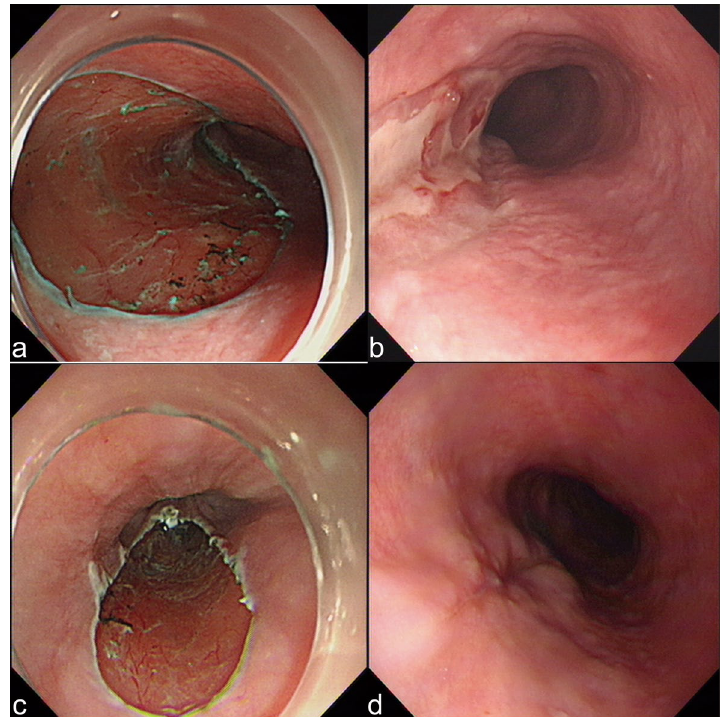
Figure 4. Artificial wounds detected from endoscopy. ( a ) Artificial ulcer remained from ESD in the control group. ( b ) The ulcer bed 2 weeks later in the control group. ( c ) The wound of ESD in the experimental group. ( d ) The ulcer bed 2 weeks later in the experimental group. The wounds in the experimental group showed less severity than the control group when detected by endoscopy 2 weeks later. ESD, endoscopic submucosal dissection.